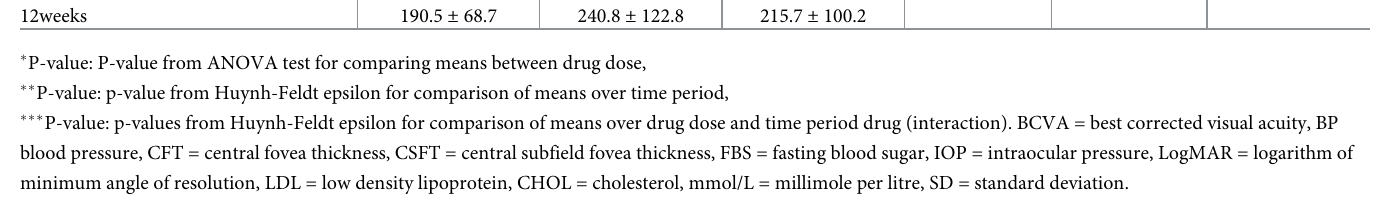
Ziv-aflibercept and aflibercept are identical fusion proteins comprising of the Fc portion of human immunoglobin IgG1 and extracellular matrix domains of VEGF receptors 1 and 2 [15]. They act as decoy receptors by binding to circulating VEGF- A and B and placental growth factor. Ziv-aflibercept is an 115kDa molecule manufactured from Chinese hamster